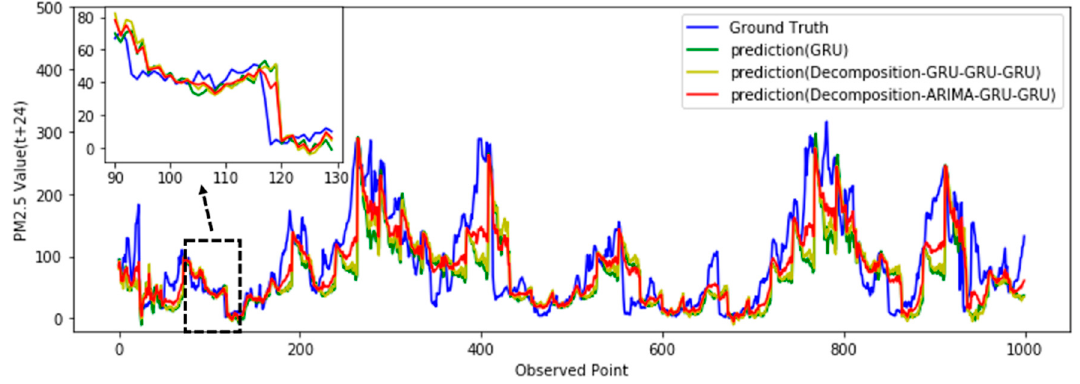
Figure 5. Comparison between the predicted results and ground truth (24 steps).